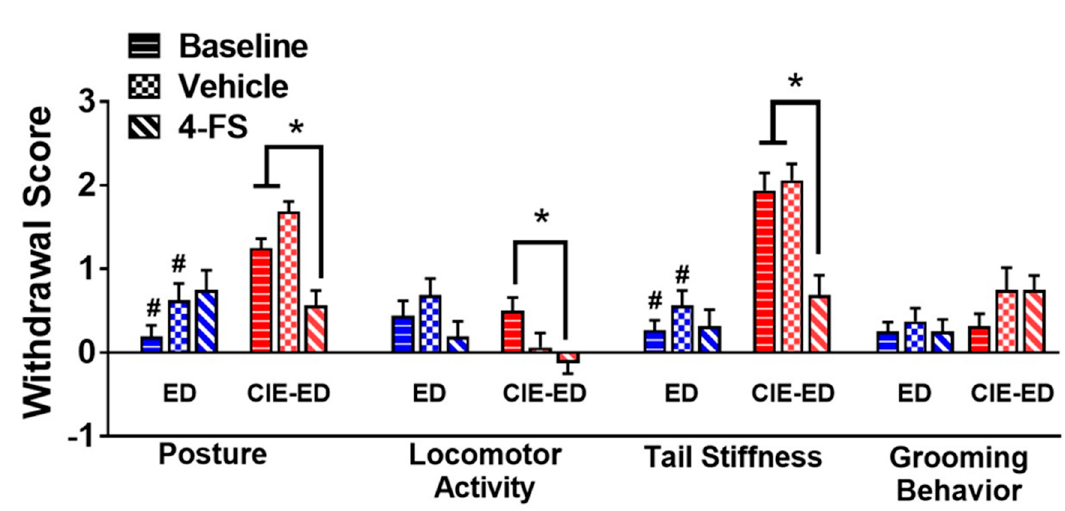
Figure 4. Physical withdrawal behaviors in ethanol drinking (ED) and CIE ‐ ED rats with vehicle and 4 ‐ FS treatment. Withdrawal behaviors are evident in CIE ‐ ED rats. Signs of ethanol withdrawal, i.e., aberrant body posture, locomotor activity and tail stiffness were reduced by 4 ‐ FS in CIE ‐ ED rats. n = 7–8/group. * p < 0.05 compared to baseline and vehicle days, within ‐ subject. # p < 0.05 vs. CIE ‐ ED rats, between ‐ subject. Data are expressed as mean ± S.E.M.